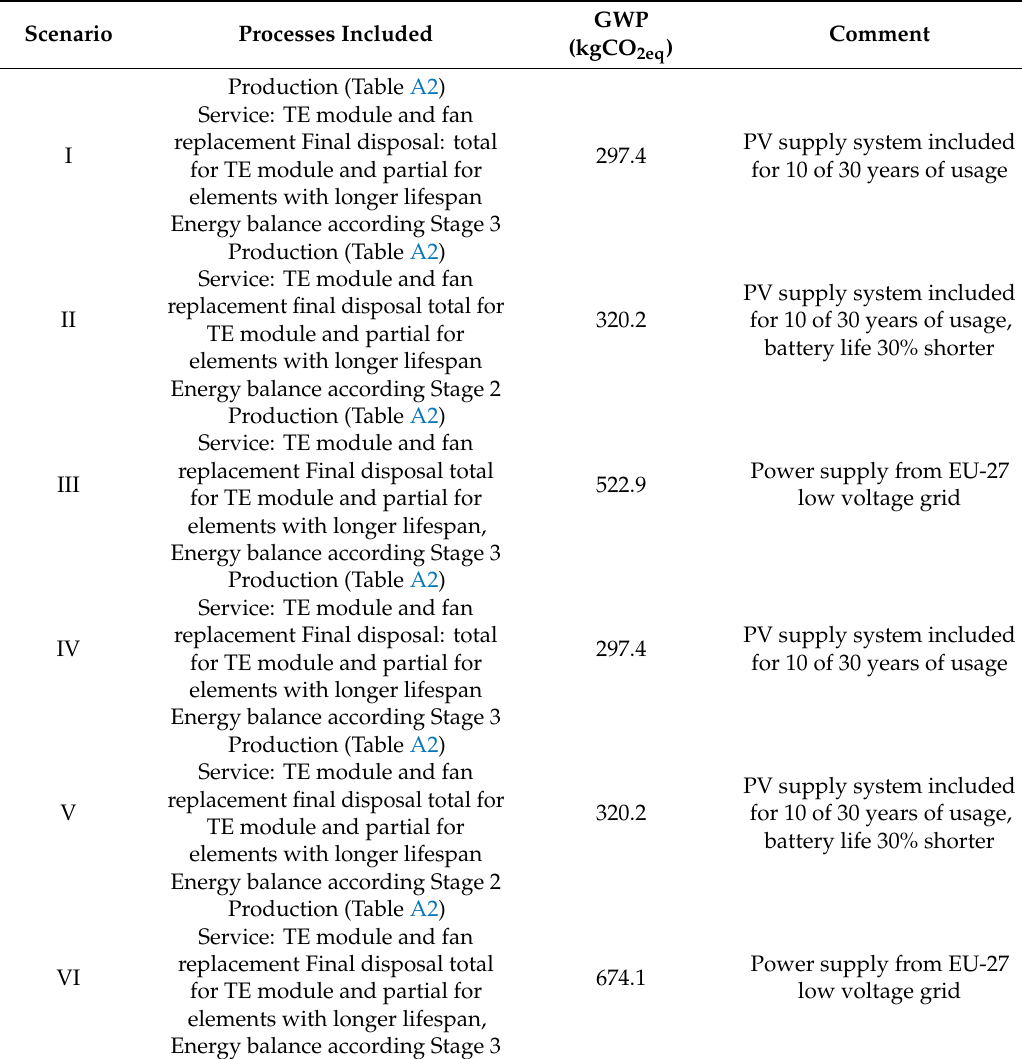
Table A4. Assumptions for LCA and GWP (total) of TE cooling system with heat recovery applied in Stage 2 and